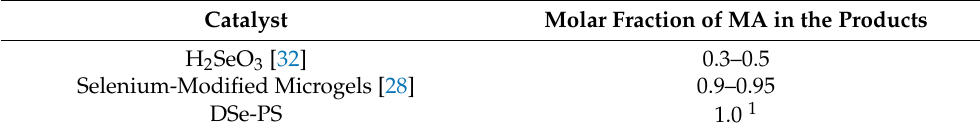
Scheme 5. Oxidation of acrolein by H 2 O 2 catalyzed by DSe-PS in methanol.